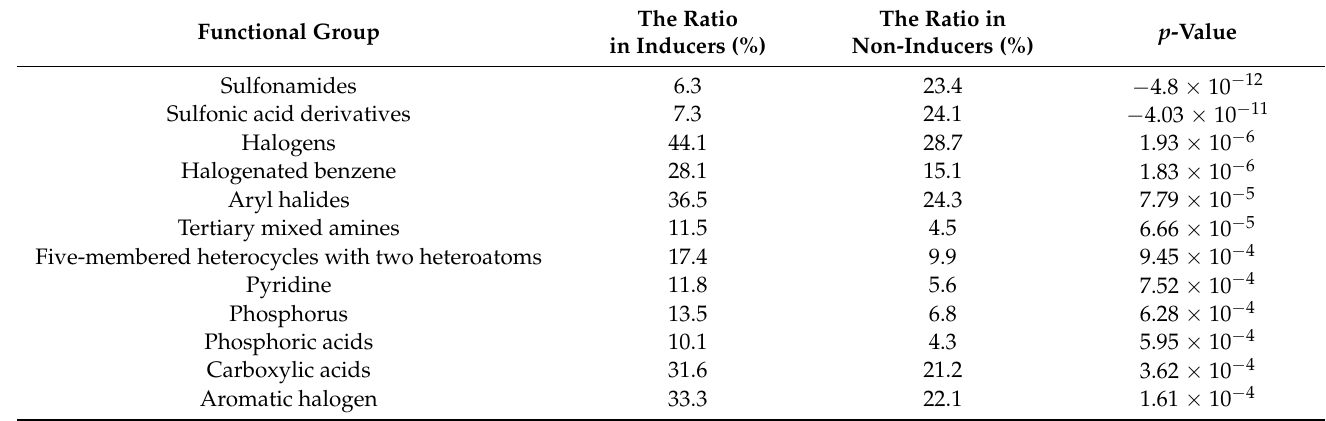
Table 3. Functional groups overrepresented in inducers and non-inducers are listed as well as the p-value of the respective